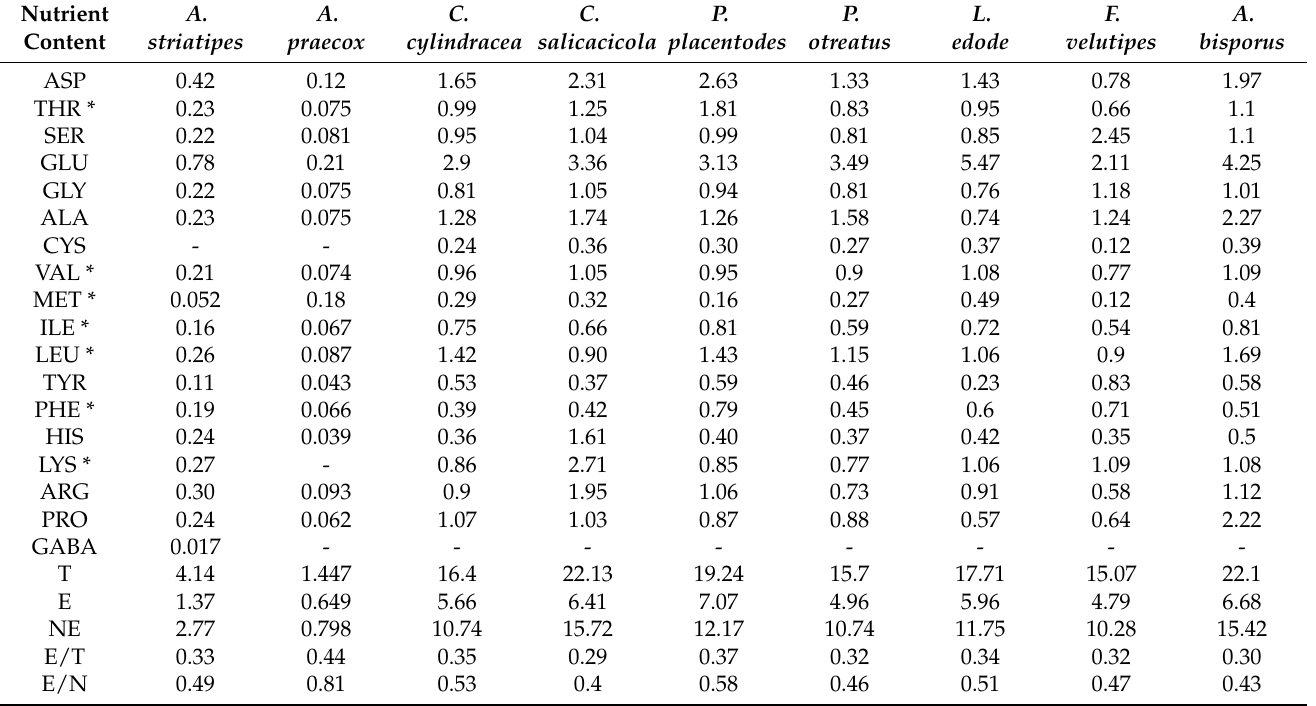
Table 3. Nutrient content of A. striatipes and other eight edible mushrooms (g/100g dry weight). Missing data are indicated by